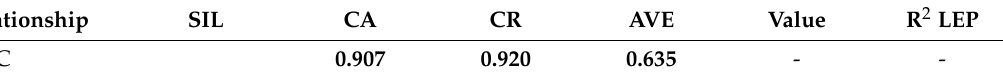
Table 5. PLS validity, reliability, and R 2